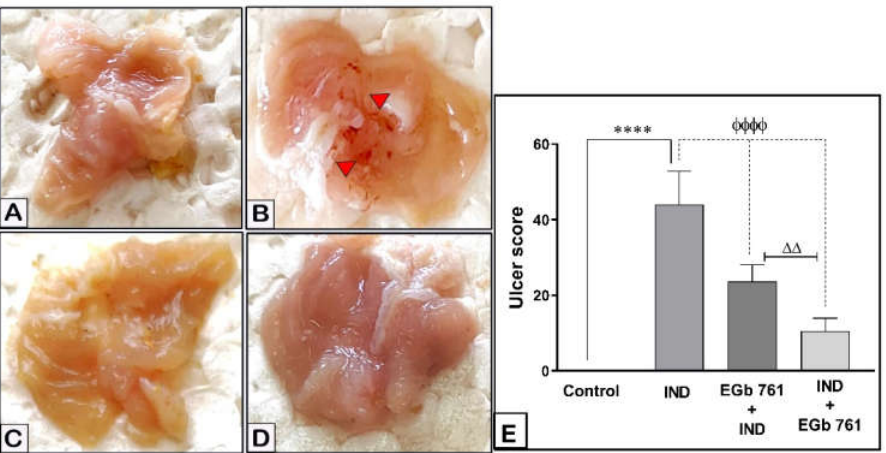
Figure 1. The effects of IND and EGb 761 on the gastric mucosa (macroscopic pictures and damage score). Results are represented as mean ± SEM (n = 6). ( A ) Control, ( B ) IND-induced ulcer, ( C ) EGb 761 pre-treatment, ( D ) EGb 761 treatment, ( E ) ulcer index scores. **** ( p < 0.0001) significantly different from control. ϕϕϕϕ ( p < 0.0001) significantly different from the ulcer group. ΔΔ ( p < 0.01) significantly different from EGb 761+IND (Prophylactic EGb 761) group. IND: Indomethacin; EGb 761: Standardized G. biloba extract.